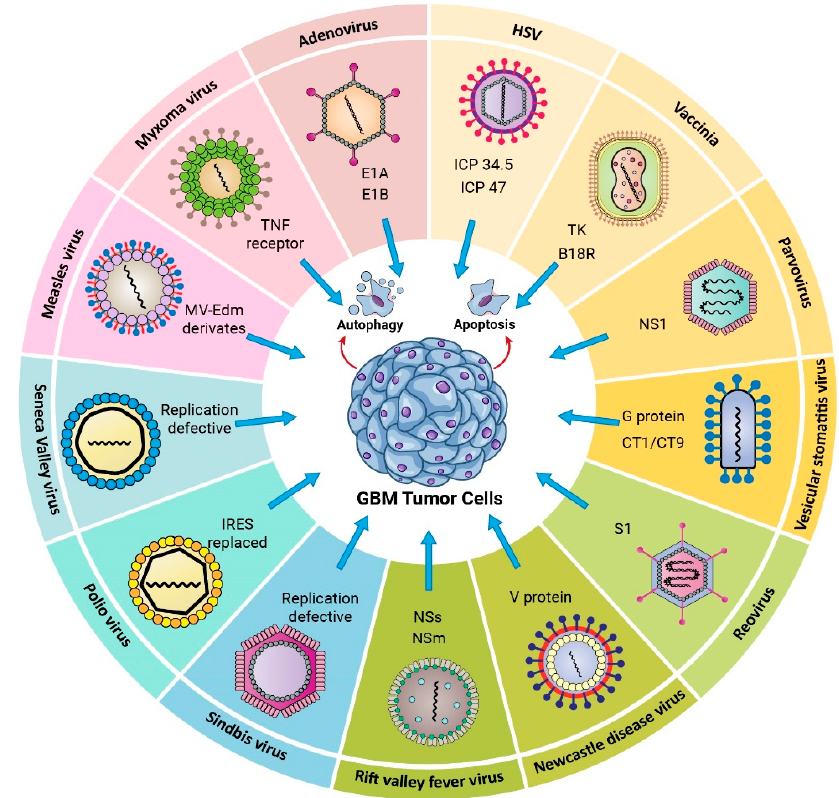
Figure 1. Oncolytic viruses used in Glioblastoma virotherapy. HSV (Herpes simplex virus); ICP34.5,ICP47 knocked out. Vaccinia virus; Tk, B18R knocked out. Parvovirus; NS1 knocked out. Vesicular Stomatitis Virus; M51,G protein, CT1/CT9 knocked out. Reovirus; SL knocked out. Newcastle disease virus; V protein knocked out. Rift Valley fever virus; NSs, NSm knocked out. Sindbis virus (Replication deficient). Poliovirus (IRES replaced), Seneca virus (Replication deficient), Measles (MV-Edem derivates), Myoxoma; TNF receptor knocked out. Adenovirus; E1A, E1B knocked out.